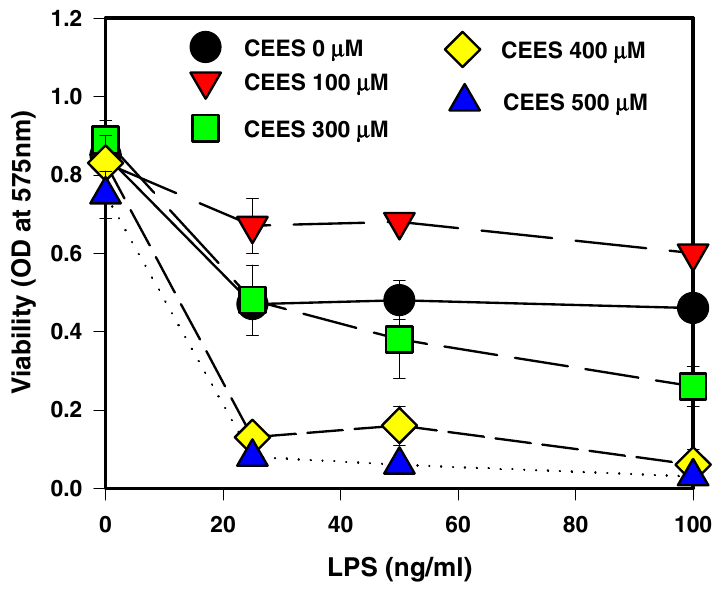
Figure 2 Cell viability as a function of LPS and CEES concentration. CEES at concentrations greater that 300 µ M were toxic (p < 0.05) to RAW 264.7 macrophages at LPS levels of 25 ng/ml or greater. Cell viability was measured, after 24 hours, by the MTT assay as described in the